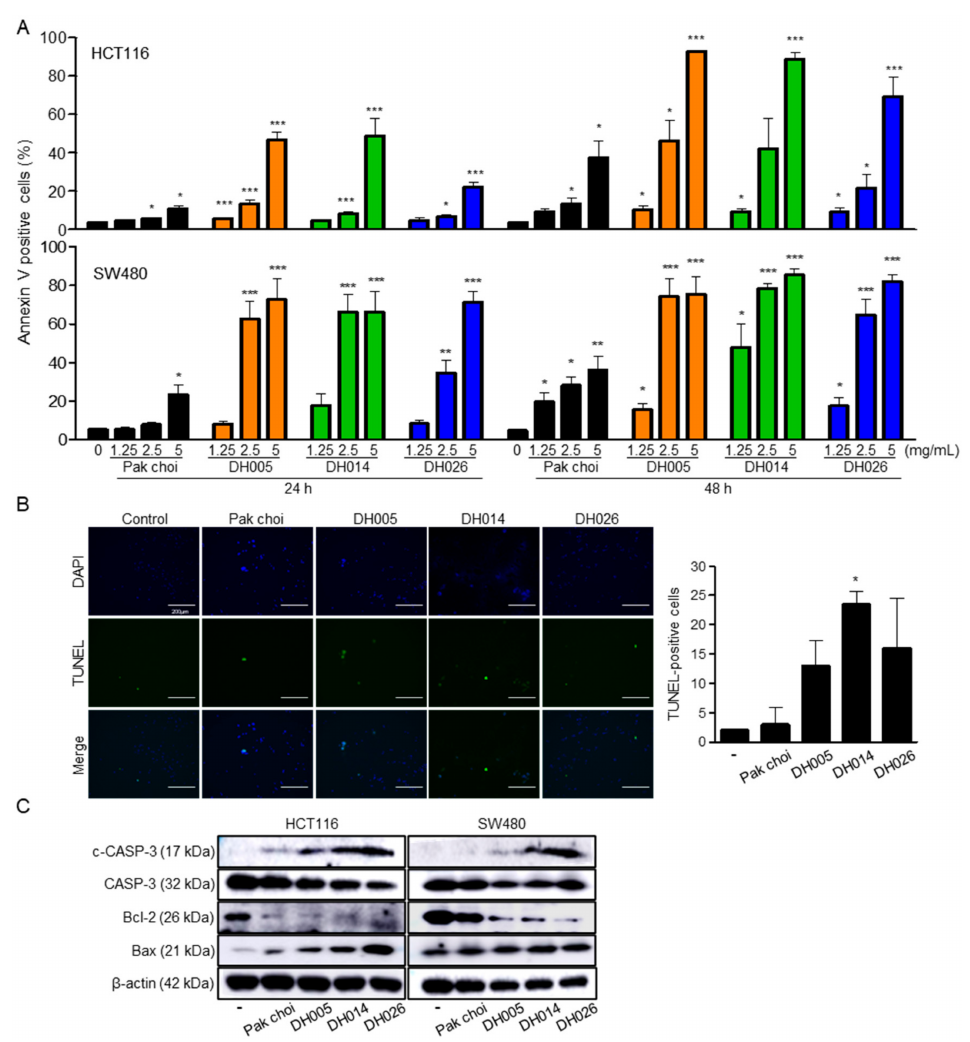
Figure 4. Effects of high glucosinolate (GSL) (HGSL) doubled haploid (DH) lines (DHLs) (DH005, DH014, and DH026) on apoptosis in human colorectal cancer (CRC) cells. ( A ) HCT116 and SW480 cells were treated with each HGSL DH or pak choi (PC) extract for 24 or 48 h. The treated cells were double- stained with fluorescein isothiocyanate (FITC)-Annexin V and propidium iodide (PI) and analyzed using flow cytometry. Apoptotic cells were quantitated as a percentage of Annexin V-positive cells. Data represent the mean ± SEM of three independent experiments (*, p < 0.05; **, p < 0.01 and ***, p < 0.001 versus control). ( B ) The 24 h-treated HCT116 cells were stained with terminal deoxynucleotidyl transferase dUTP nick end labeling (TUNEL) and 4 (cid:48) ,6-diamidino-2-phenylindole (DAPI) and analyzed by confocal microscopy (scale bar, 200 µ m). TUNEL-positive cells were counted on at least three fields in each well, and data represent the mean ± SD (*, p < 0.05). ( C ) HCT116 and SW480 cells were treated with each sample (2.5 mg/mL) for 24 h. Then, the whole cell